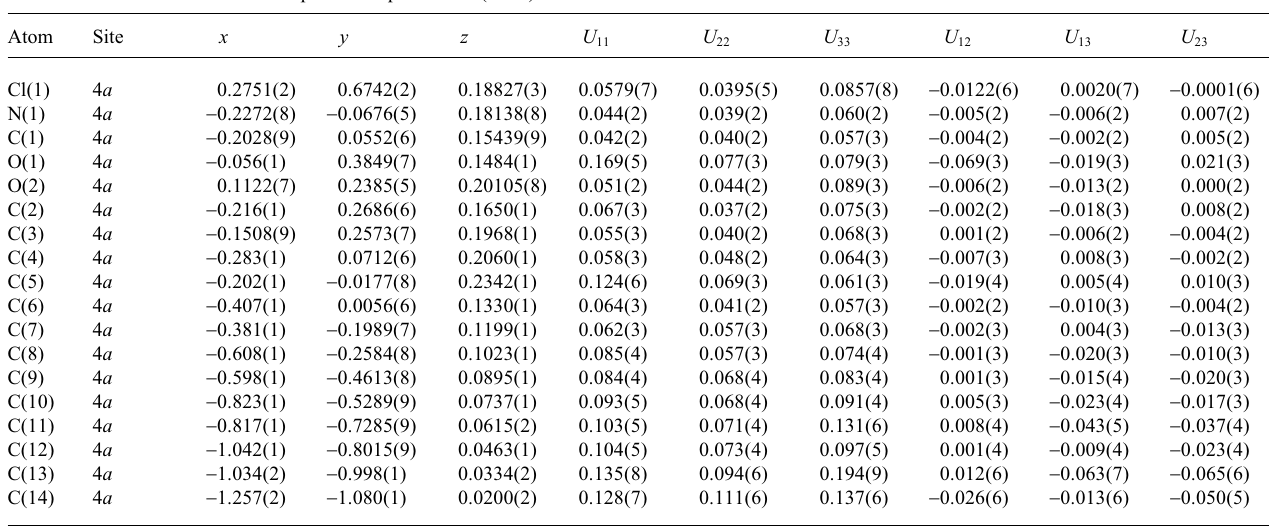
Table 3. Atomic coordinates and displacement parameters (in Å 2 ) .